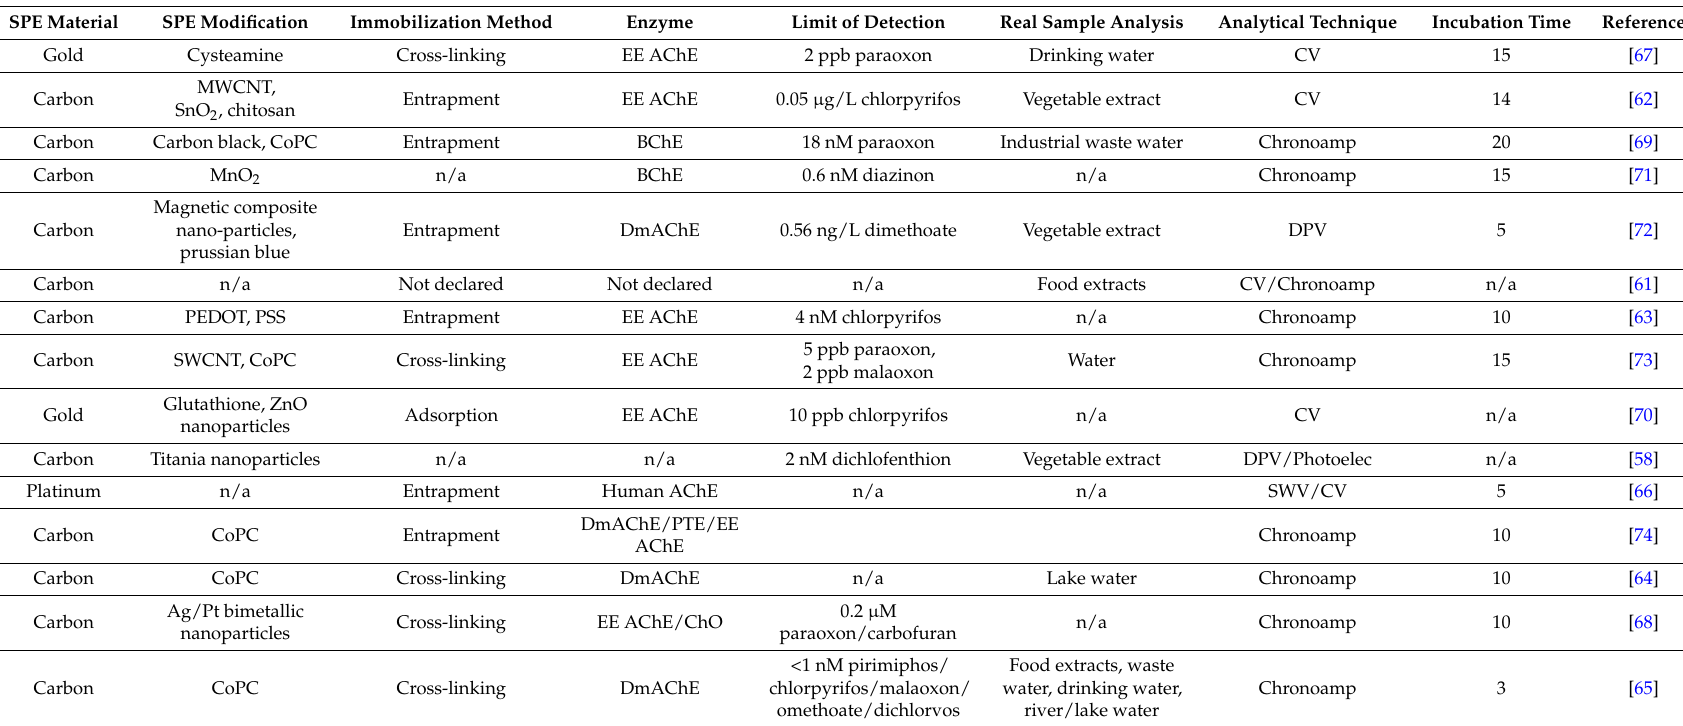
Table 7. Reports of screen-printed electrodes for organophosphate